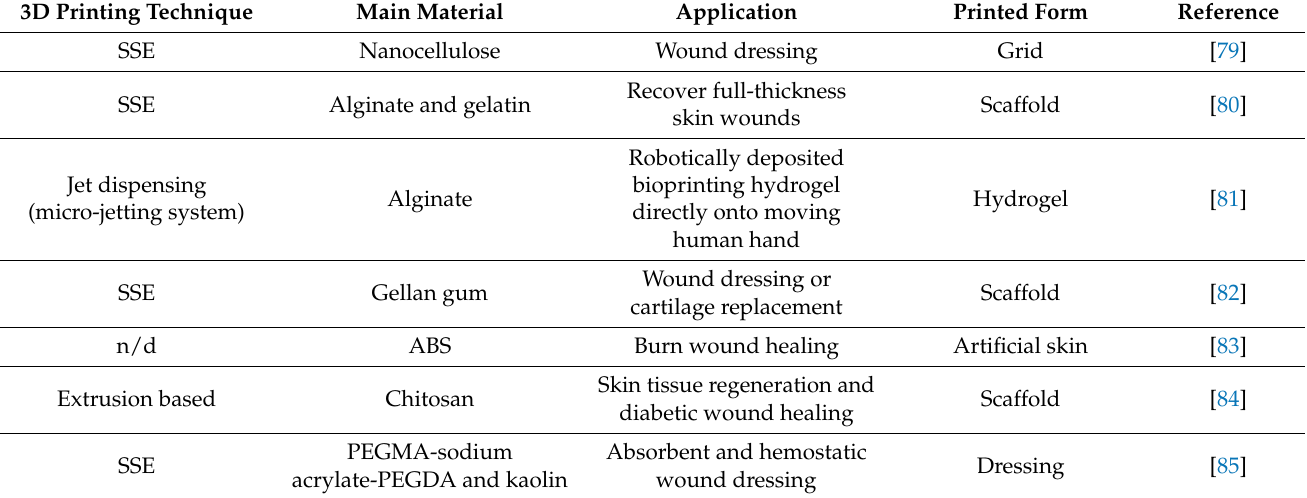
Table 1. 3D-printed plain